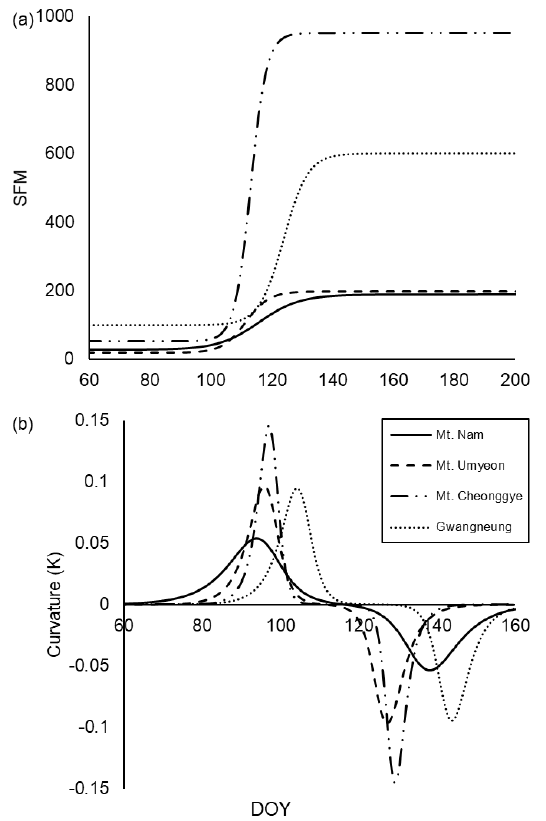
Figure 8. SFM logistic models of green-up ( a ) and curvature K ( b ) in study.